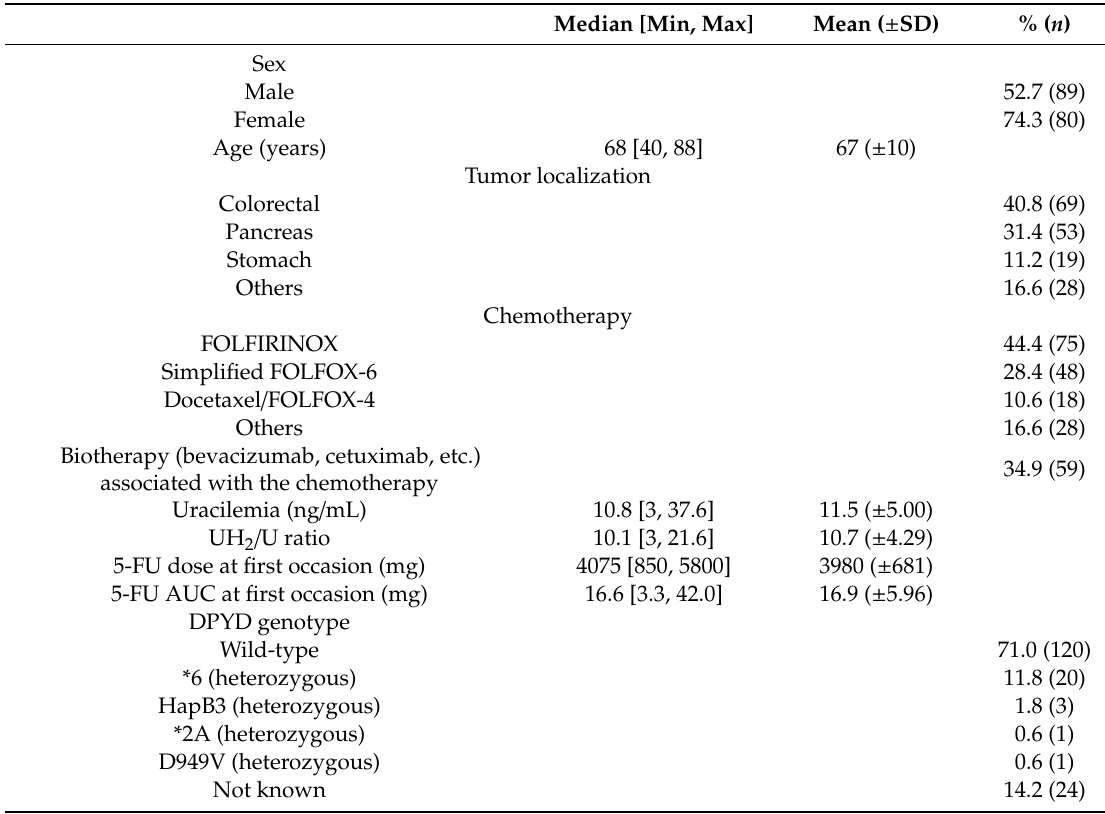
Table 1. Baseline patient characteristics. N =